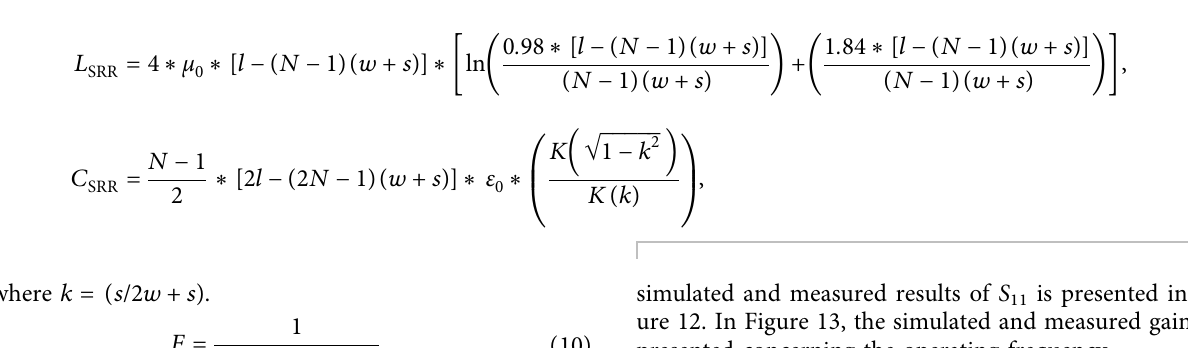
11 comparison plot of the antenna with and without